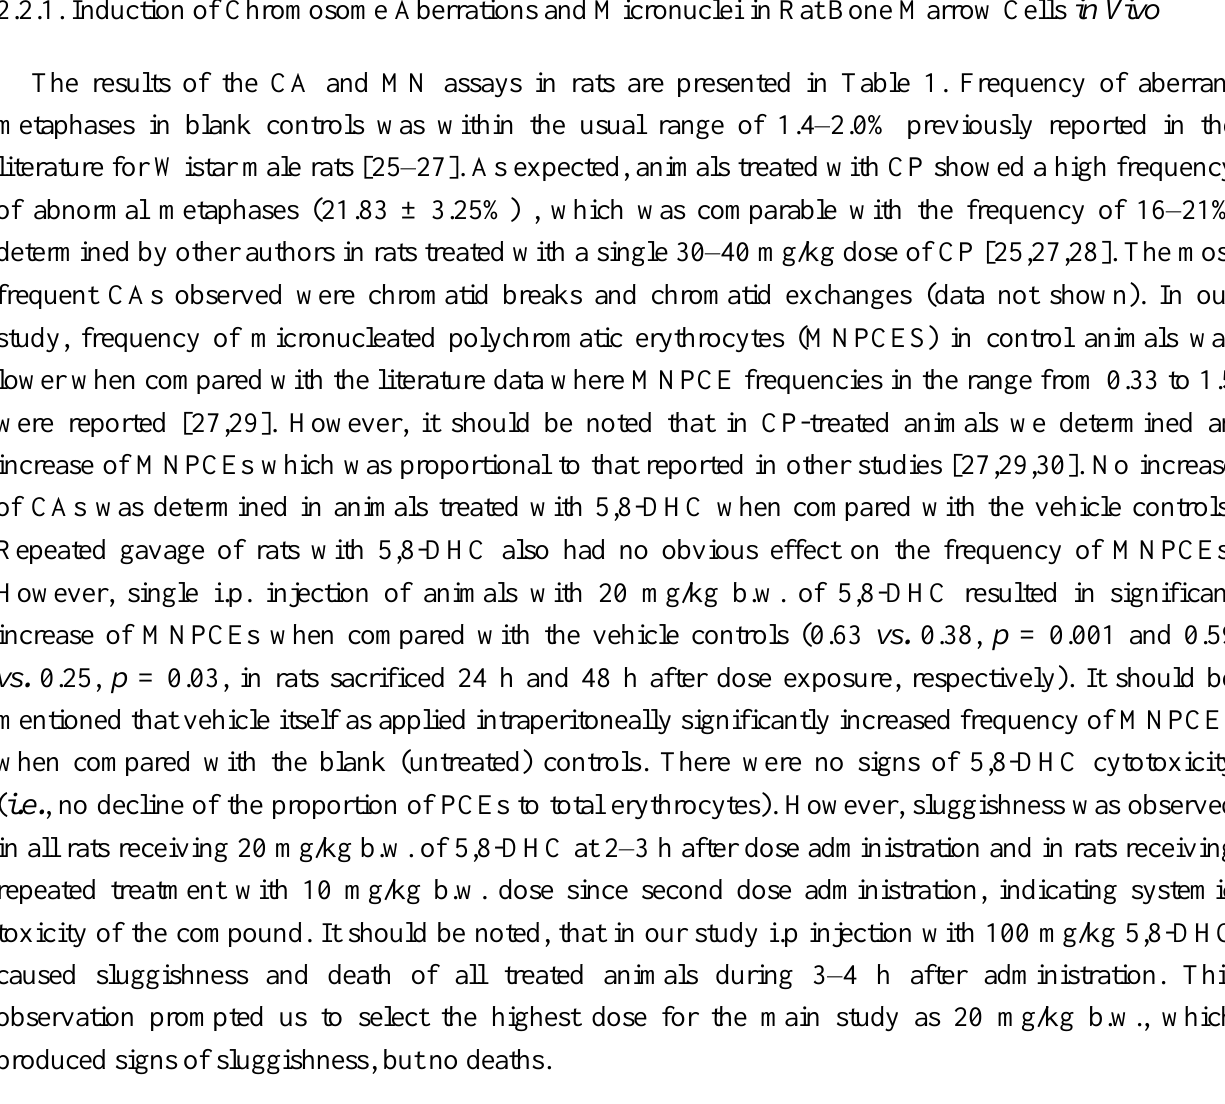
Table 1. Induction of chromosome aberrations and micronucleated polychromatic erythrocytes (MNPCE) in Wistar rat bone marrow cells after treatment with